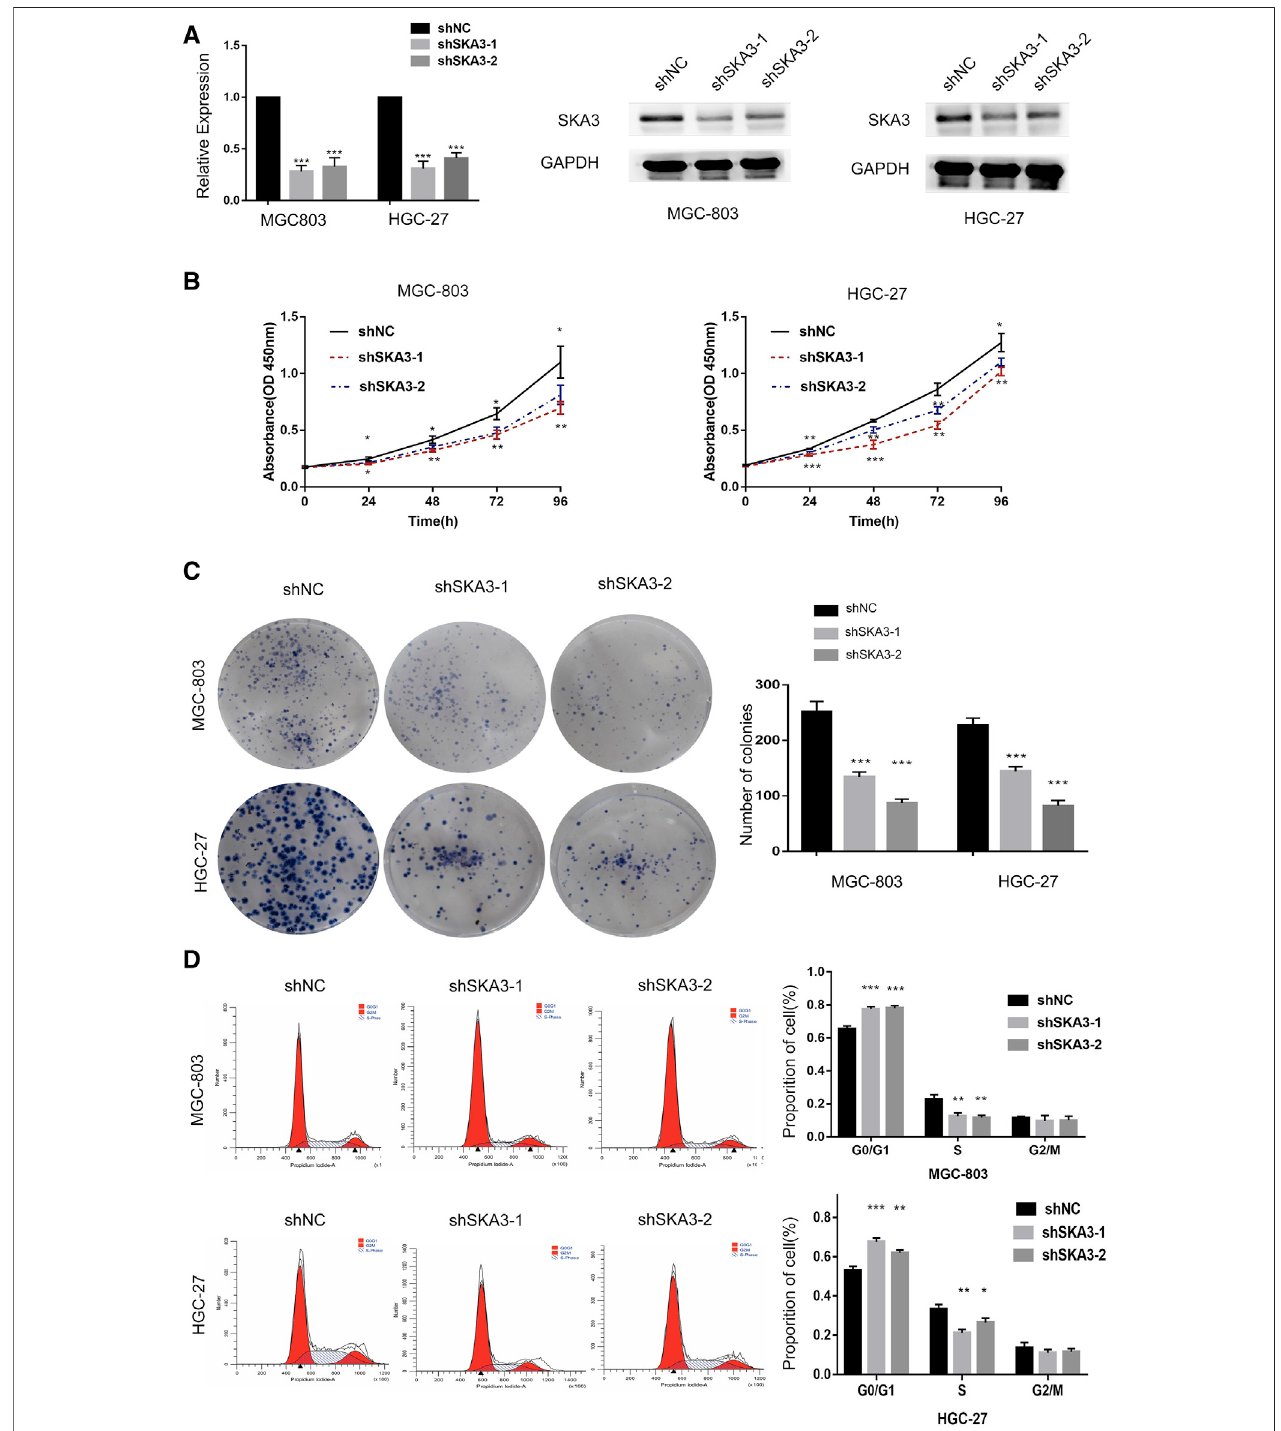
FIGURE 2 | SKA3 promotes proliferation in gastric cancer. (A) mRNA and protein levels of SKA3 after transfection with shSKA3 lentivirus in MGC-803 and HGC- 27. (B) CCK-8 cell proliferation assay detects cell viability by silenced for SKA3 in MGC-803 and HGC-27. (C) Cloning experiment detects cell growth by silenced for SKA3 in MGC-803 and HGC-27. (D) Flow cytometry detects cell cycle n by silenced for SKA3 in MGC-803 and HGC-27. Data are shown as mean ± SD for triplicate experiments. The two-tailed Student ’ s unpaired t -test was used. * p < 0.05, ** p < 0.01, *** p < 0.001.